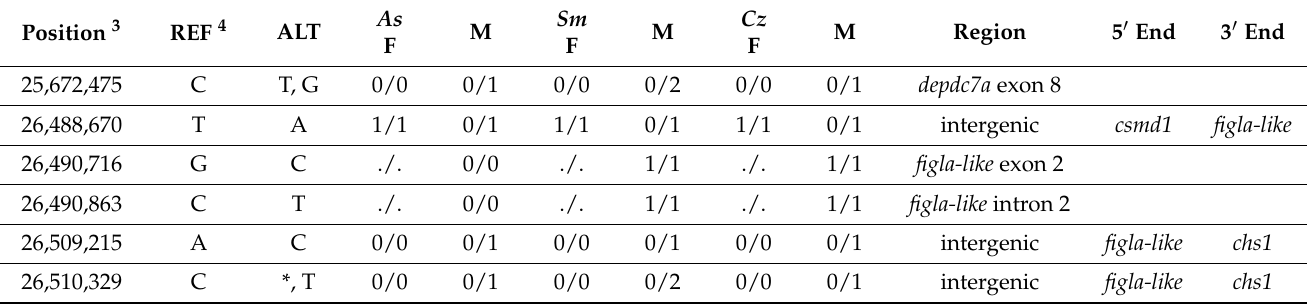
Table 1. Sequence variations in the SD region 1 on the O. aureus genomic map, which fit an XY model in Amherst strain ( As ), S. melanotheron 2 ( Sm ), and C. zillii ( Cz ).